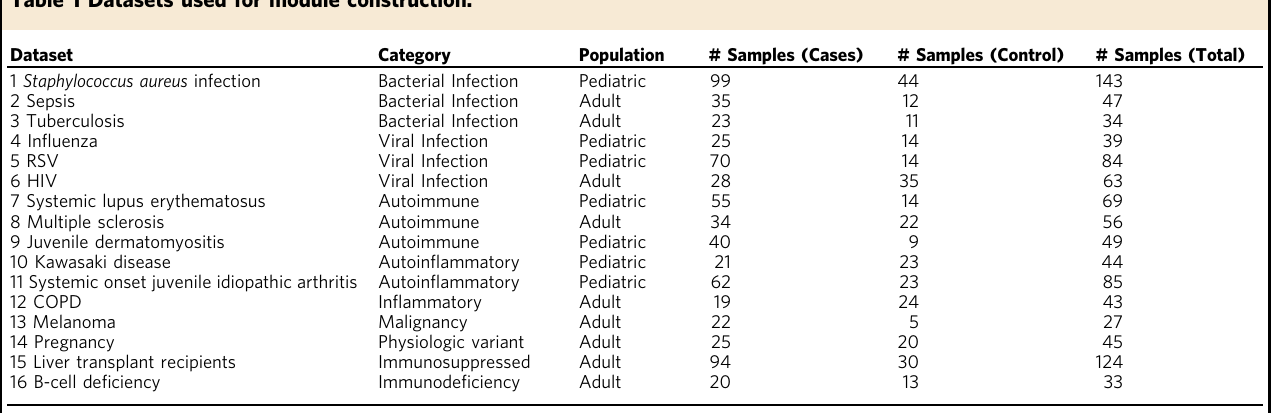
Table 1 Datasets used for module